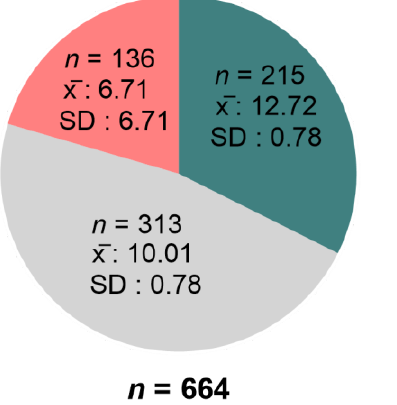
Figure 1. Distribution of knowledge score level of participants. x ¯: mean, SD: standard deviation. Knowledge scores were categorized according to Bloom’s cut-off points as 80.0–100.0% (high level, 12–15 points), 60.0–79.0% (medium level, 9–11 points), and ≤ 59.0% (low level, 0–8 points).